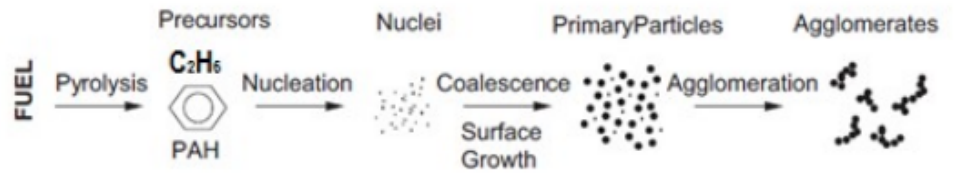
Figure 1: Stages of the soot formation process [13].